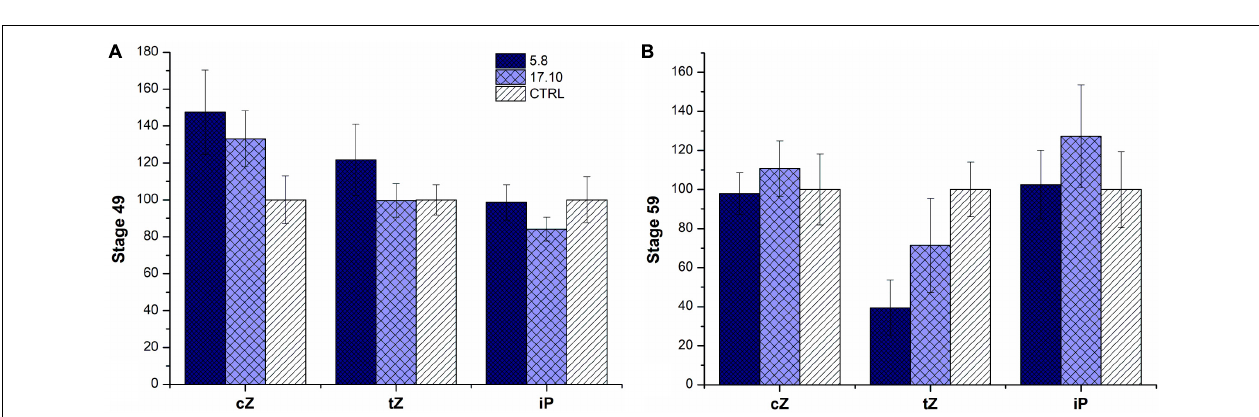
FIGURE 3 | Specific enzymatic CKX activity (pkat/mg) in the spike of KD-CKX1 and KO-CKX1 transgenic lines at different stages of development. Activity was measured at three developmental stages of KD-CKX1 lines (5.8, 4.3, 17.10, and 21.4), KO-CKX1 mutant lines (39.4, 40.4, and 48.1) and control plants. Stages are named according BBCH scale: stage 49 [booting: first awns visible (in awned forms only)]; stage 59 (end of heading: inflorescence fully emerged); stage 71 (watery ripe: first grains have reached half their final size). Values are mean ± SE ( n = 5 to 8). A non-parametric Kruskal–Wallis Anova & Median test analysis was performed followed by a post hoc multiple comparison of mean rank (Statistica v. 13.3); ∗ p < 0.01, ∗∗ p < 0.001, ∗∗∗ p < 0.0001, ∗∗∗∗ p < 0.00001.